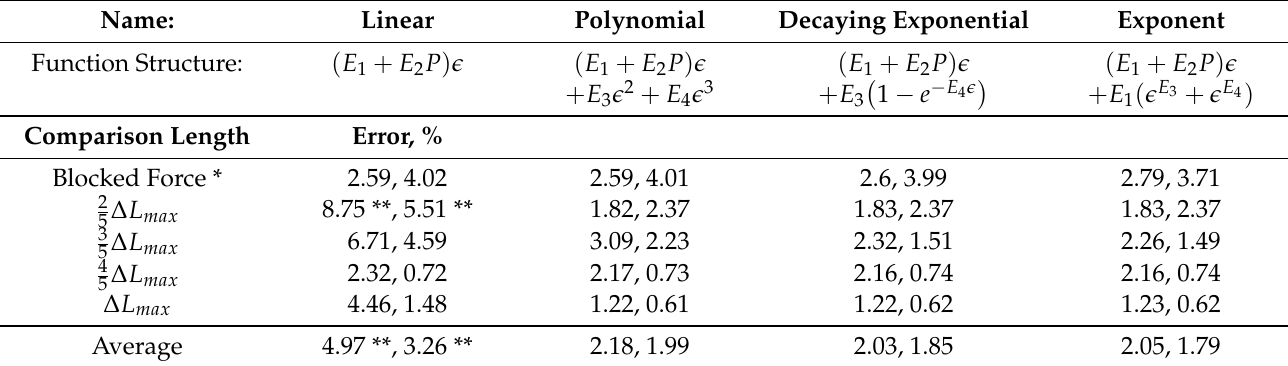
Table 3. Error Comparison for the four different stress function models. Two error values are shown for FAM1 and FAM2, respectively.